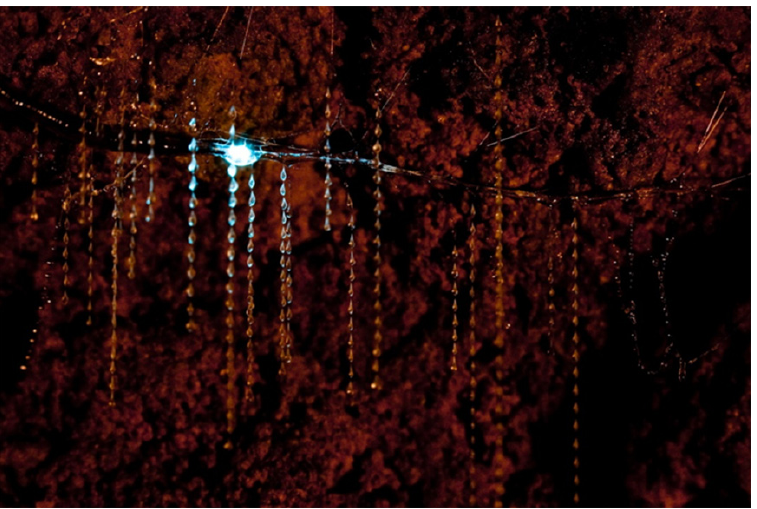
Figure 8. Arachnocampa (Arachnocampa) luminosa (Skuse, 1891) larva in its tubular nest from which hang down numerous silk threads with regularly arranged sticky droplets. Image courtesy of Chris Wills. From Conti et al. [5].